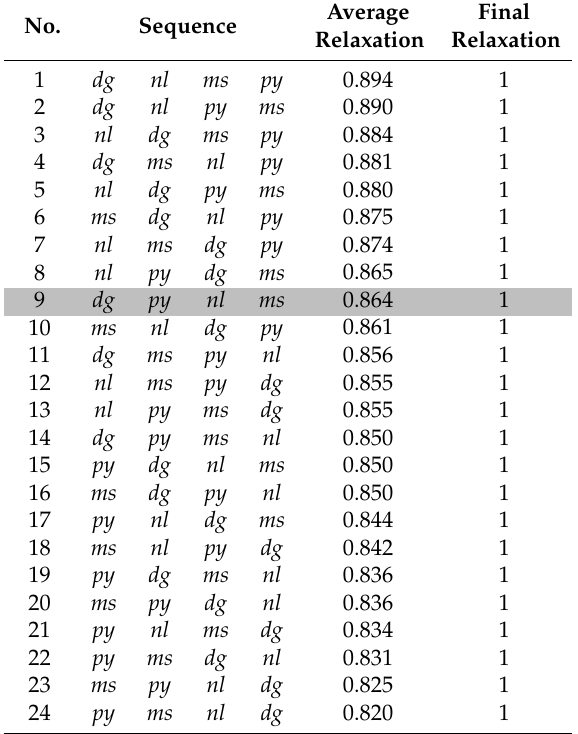
Table 5. Effect of different adaptation sequences on the average relaxation for outdoor environments. The list is ordered according to decreasing final and average relaxation. The highlighted sequence is the order used in the heuristic